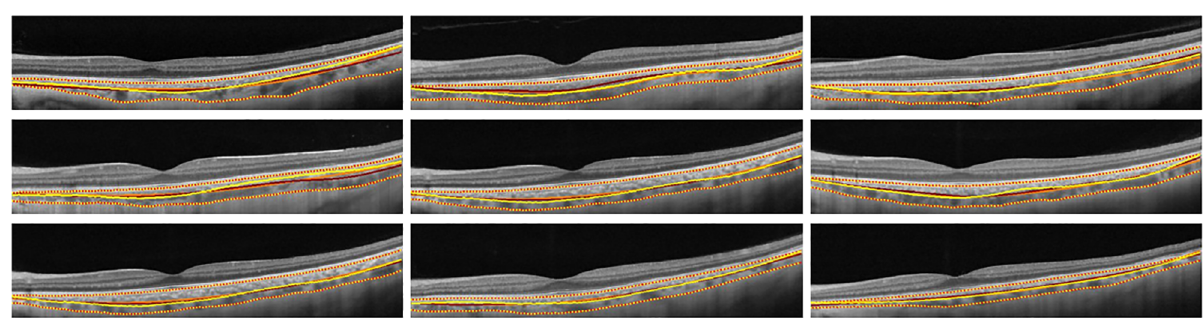
Fig 4. Automated vs manual markings of Haller’s layer; yellow—Automated, orange—Manual marking by grader-1, red—Manual marking by grader-2, yellow-red stripes—Choroid inner and outer